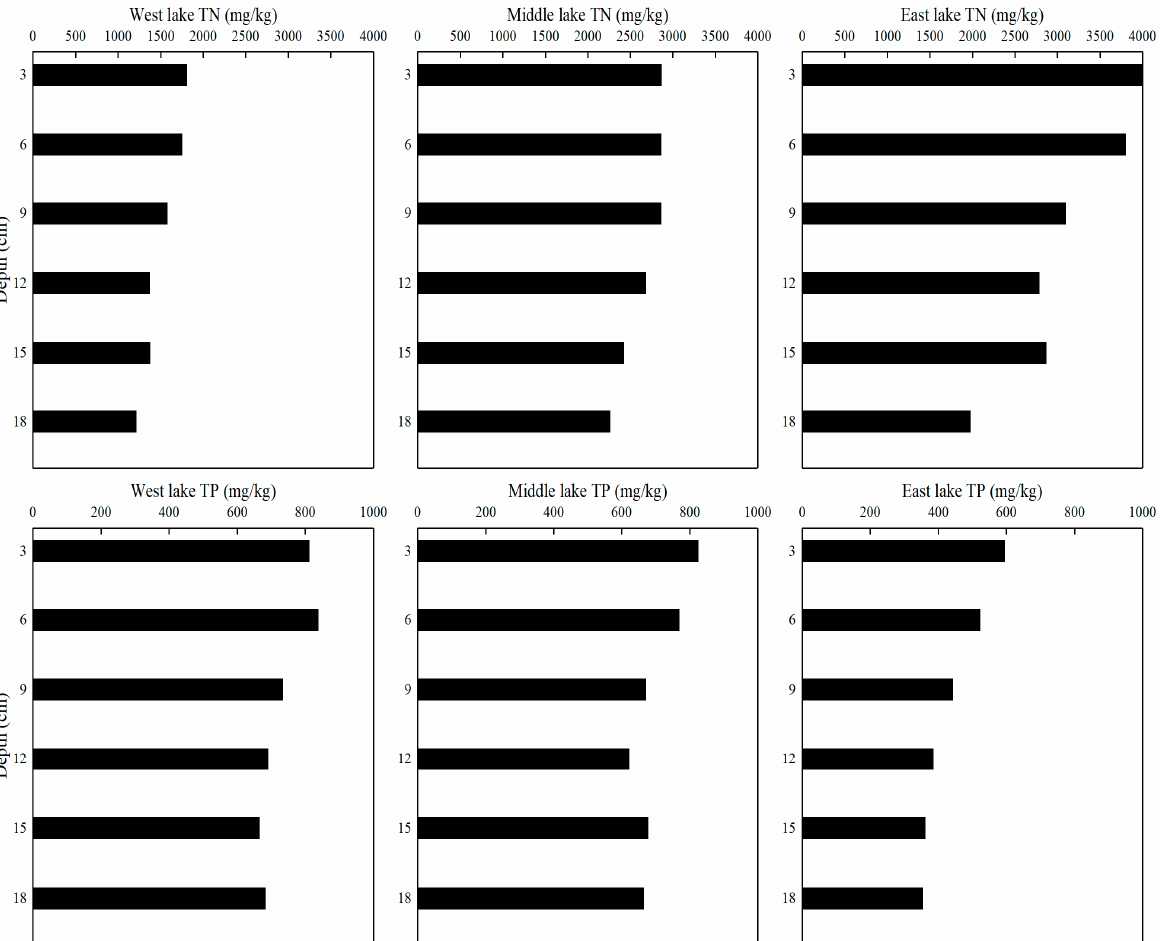
Figure 6. The sediment concentration of TN and TP with depth in the three lake areas of Lake Yang- cheng.